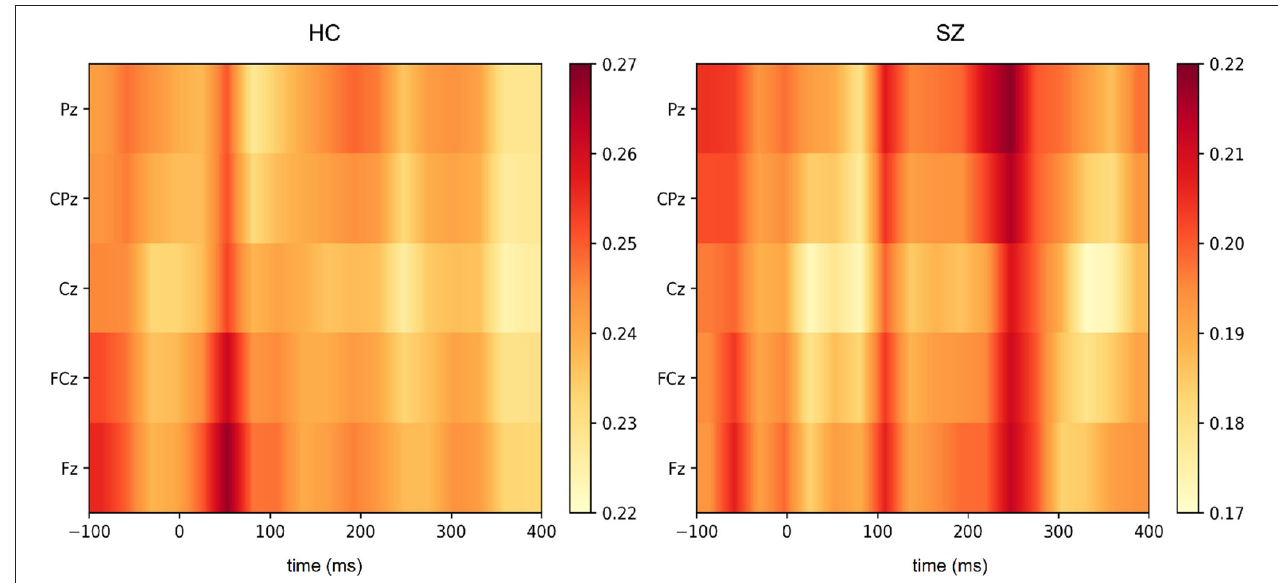
FIGURE 8 | Heatmaps (yellow to red colormap) obtained using Grad-CAM for the segments most likely to belong to HC and SZ subjects.